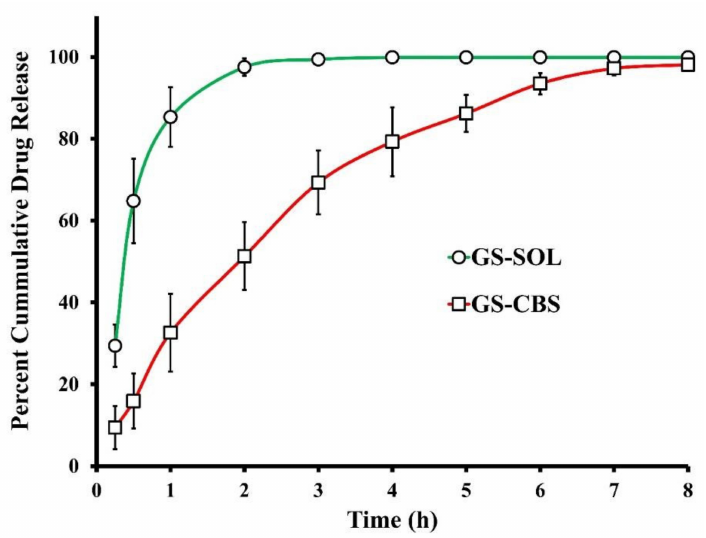
Figure 5. In vitro release profiles of GS from GS-CBS and